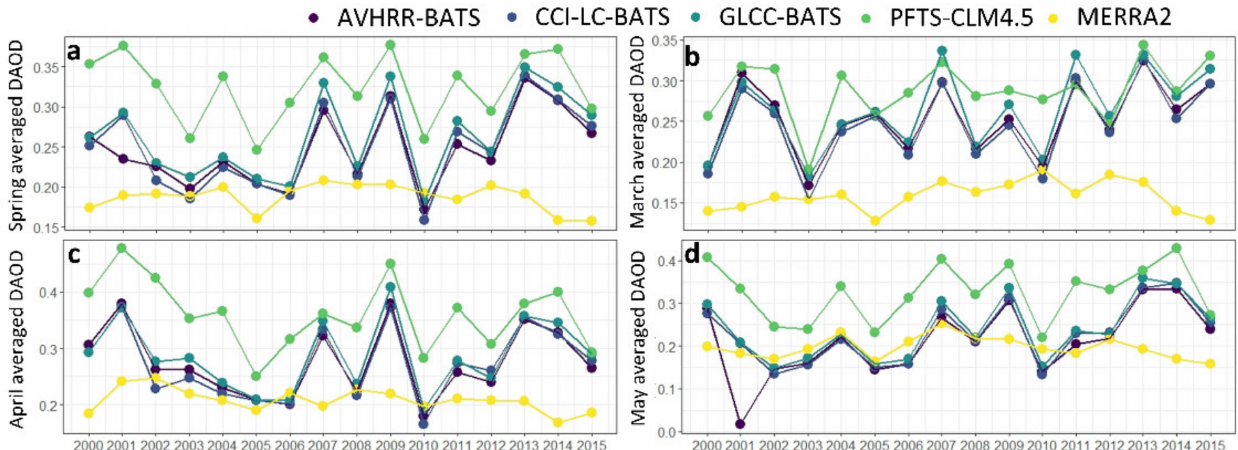
Figure A2. The trend of DAOD in spring in northern China from 2000–2015. ( a ) Spring averaged DAOD; ( b ) March averaged DAOD; ( c ) April averaged DAOD; ( d ) May averaged DAOD. (Lines 350–353 in the revised